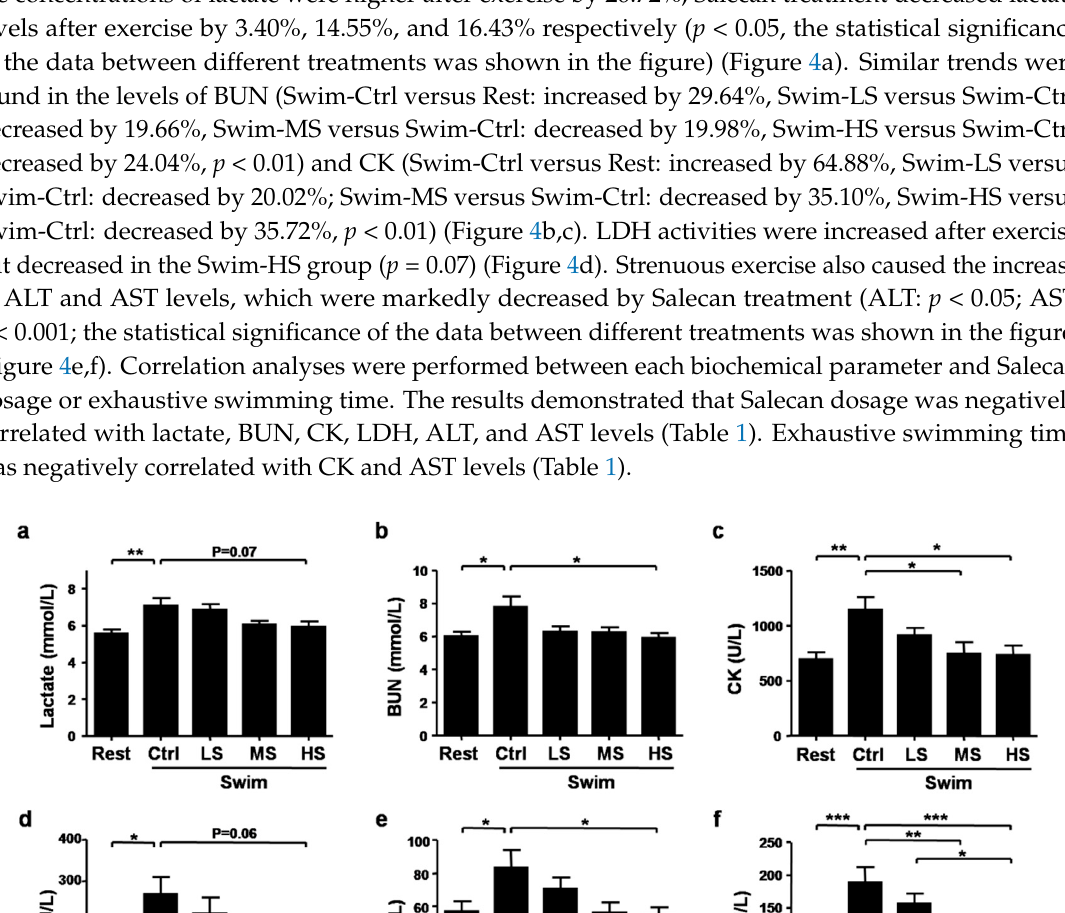
Table 1. Correlation analyses between each biochemical parameter and Salecan or exhaustive